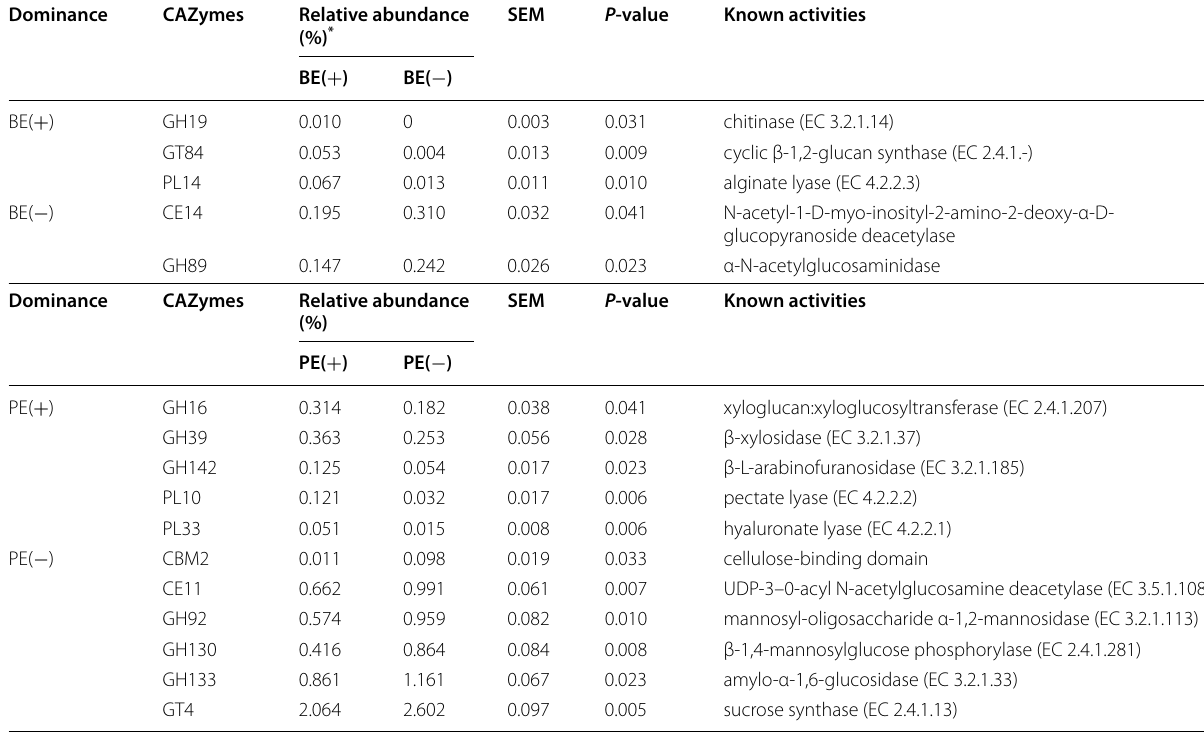
Only the CAZymes which have over 0.01% average relative abundance in at least one of the treatments [BE( BE, bacterial-enriched rumen fluid; PE, protozoal-enriched rumen fluid *Calculated based on the normalized CAZymes count